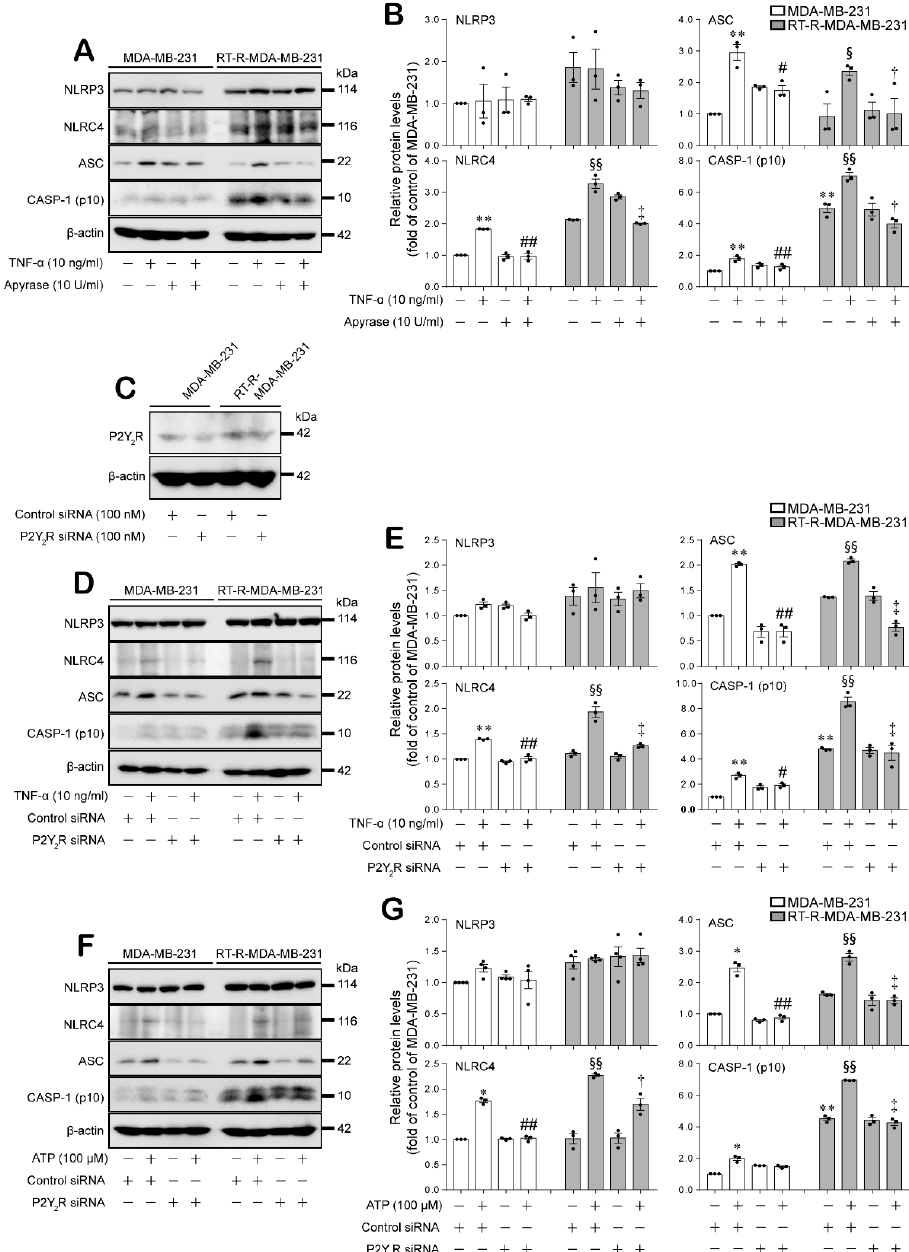
Figure 2. The inflammasome components NLRC4, ASC, and cleaved caspase-1 were induced by TNF- α or ATP in a P2Y purinergic receptor 2 (P2Y 2 R)-dependent manner in MDA-MB-231 and RT-R-MDA- MB-231 cells. ( A, B ) The cells were pretreated with apyrase (10 U/mL) for 1 h and then stimulated with TNF- α (10 ng /mL) for 12 or 24 h for the detection of cleaved caspase-1 (p10) or NLRP3, NLRC4, and ASC, respectively. The protein levels of inflammasome components were analyzed by Western blotting as described in the Methods section ( A ) and were quantified by densitometry ( B ). The values represent the mean ± SEM of three independent experiments. ** p < 0.01, compared to the control MDA- MB-231 cells; # p < 0.05, ## p < 0.01, compared to TNF- α -treated MDA-MB-231 cells; § p < 0.05, §§ p < 0.01, compared to the control RT-R-MDA-MB-231 cells; † p < 0.05, ‡ p < 0.01, compared to TNF- α -treated RT- R-MDA-MB-231 cells. ( C ) The cells were transfected with control or P2Y 2 R siRNA, and the knockdown efficiency was confirmed by Western blotting. CASP-1: caspase-1. ( D, E ) The control or P2Y 2 R siRNA-transfected cells were stimulated with TNF- α (10 ng /mL) for 12 or 24 h for the